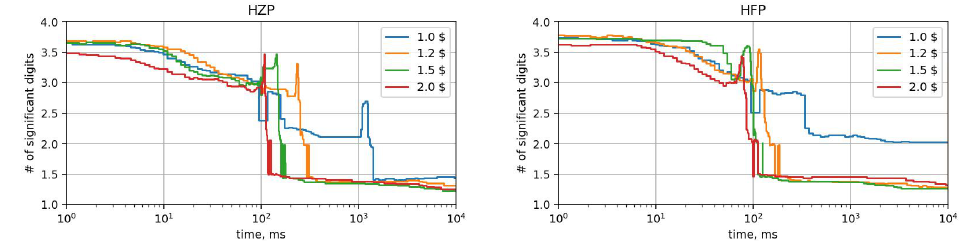
Figure 3. Mean number of significant digits over the